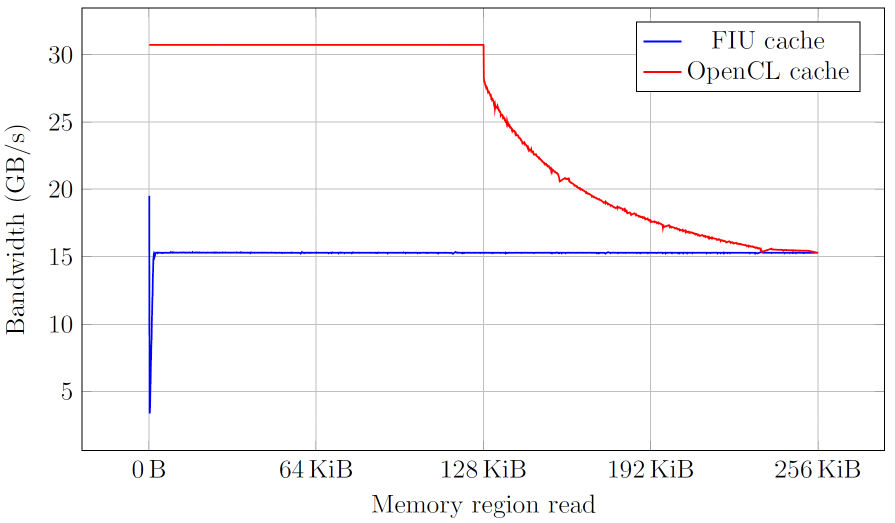
Figure 5. Bandwidth of reading src when executing kernel cache read for ulong16 pointer types. The bandwidth for both the kernel with (blue) and without (red) the volatile keyword is